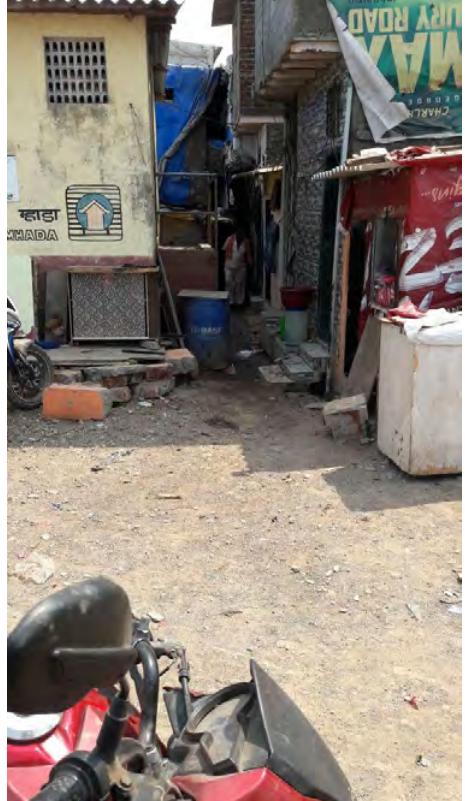
Figure 3. Gazdar Bandh slum site covered during field